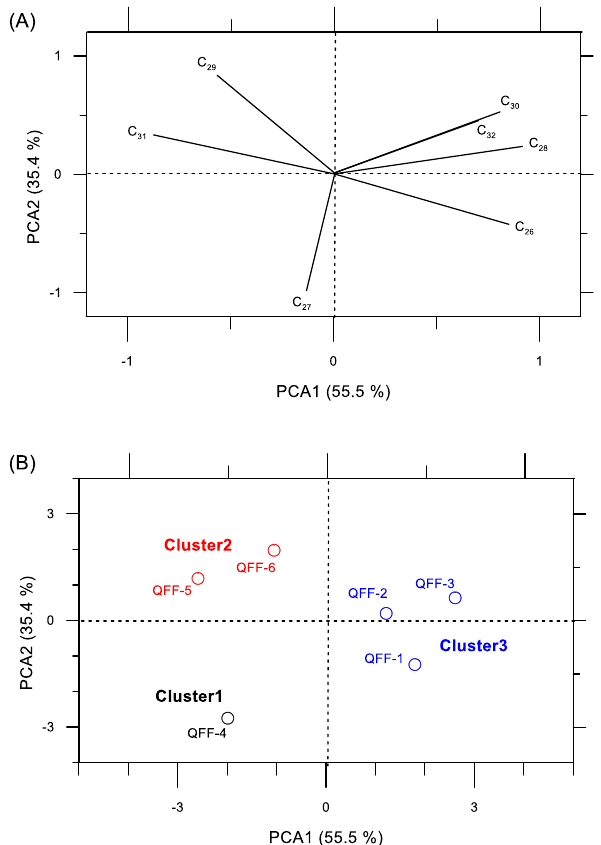
Figure 5. ( A ) Results of the Principal Component Analysis (PCA), and ( B ) the Hierarchical Clustering on Principal Components (HCPC) of the fractional abundances of HMW n -alkanes for the marine aerosol samples investigated.